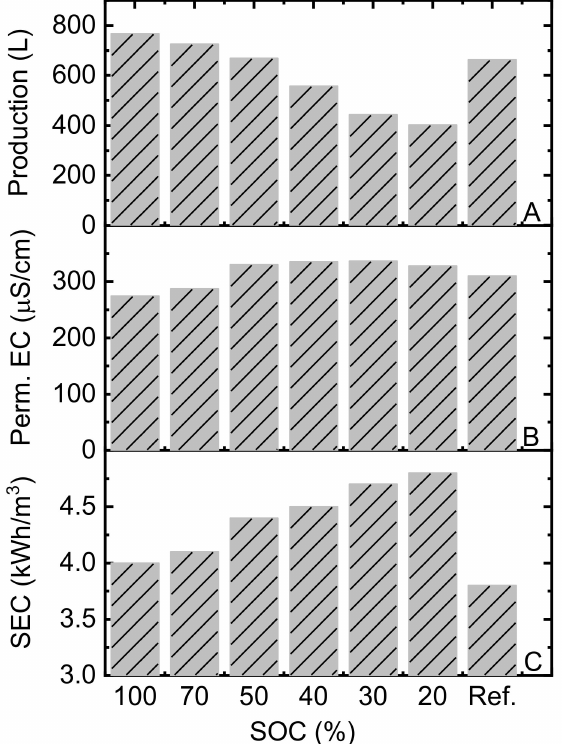
Figure 6. Key performance indicators of the PV-membrane system as a function of the initial energy storage capacity of the batteries (different SOC) on the “partly cloudy day”: ( A ) water production, ( B ) permeate EC and ( C ) SEC. Note that the Ref. represents the directly coupled system performance (without batteries), as discussed in Section